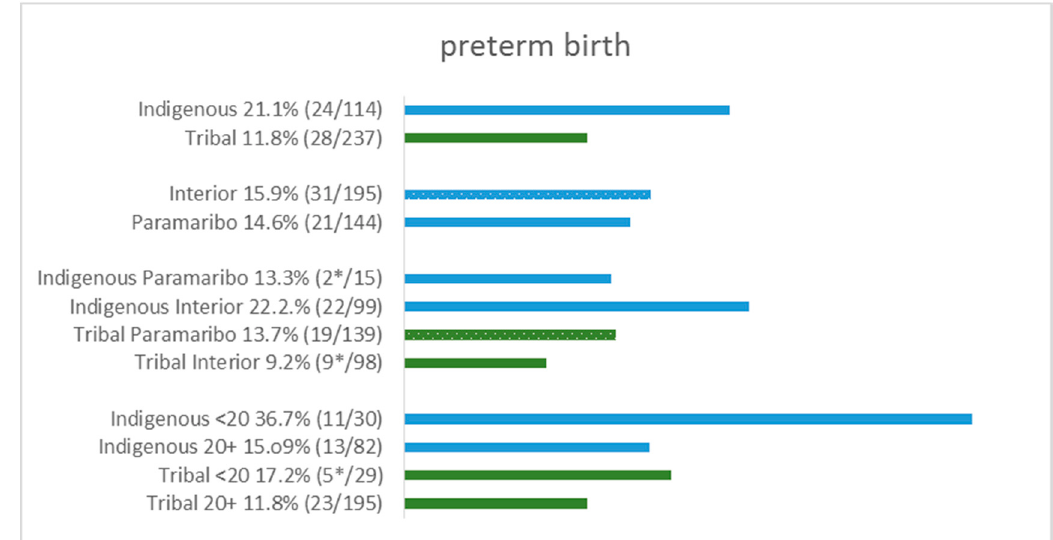
Figure 2. Rates of adverse birth outcomes stratified for ethnic background, geographical background, and age at delivery. * Rates are based on fewer than 10 ABO. Two-sample test for differences in proportions: Indigenous vs. Tribal ( p = 0.043); Interior vs. Paramaribo ( p = 1.000); Indigenous Interior vs. Indigenous Paramaribo ( p = 0.767); Tribal Interior vs. Tribal Paramaribo ( p = 0.321); Indigenous 16–19 years vs. Indigenous 20+ years ( p = 0.353); Tribal 16–19 years vs. Tribal 20+ years ( p = 0.328).